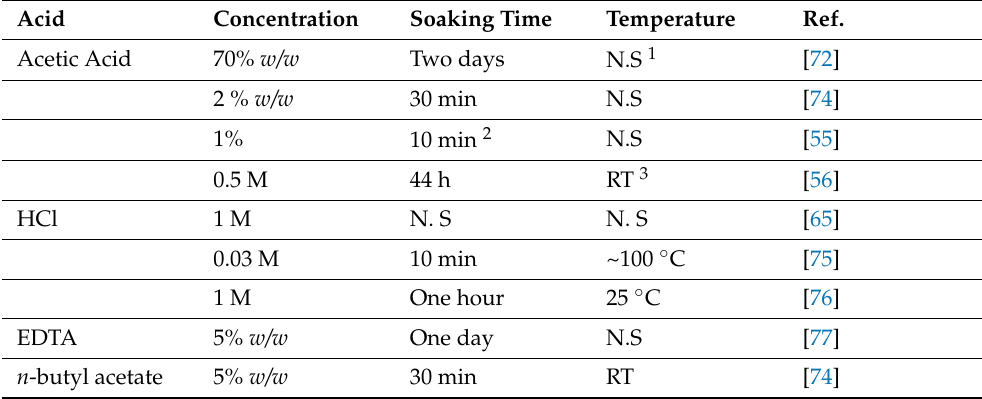
Table 1. Eggshell chemical dissolution approaches to obtain ESM. Acid Concentration Soaking Time Temperature Ref. Acetic Acid 70% w/w Two days N.S 1 [72] 2 % w/w 30 min N.S [74] 1% 10 min 2 N.S [55] 0.5 M 44 h RT 3 [56] HCl 1 M N. S N. S [65] 0.03 M 10 min ~100 ◦ C [75] 1 M One hour 25 ◦ C [76] EDTA 5% w/w One day N.S [77] 5% w/w 30 min RT